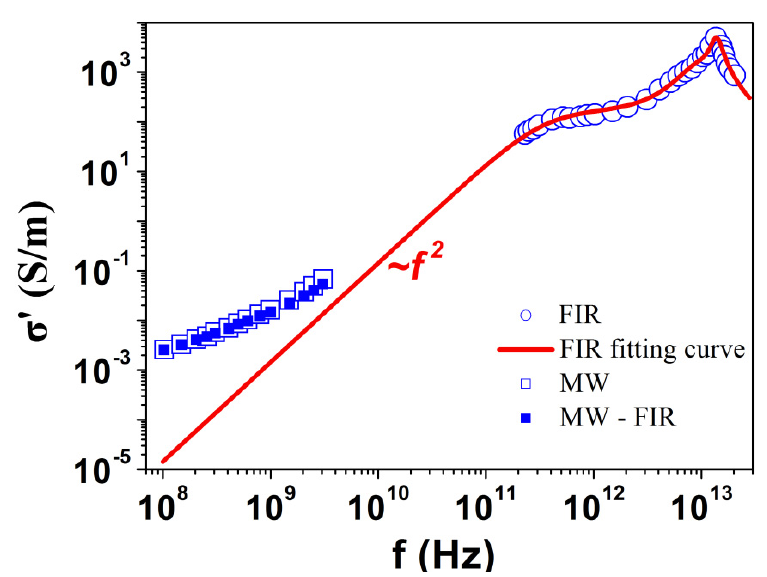
Figure 3. Real part of AC conductivity as a function of frequency of a lithium silicate glass. The blue open symbols represent experimental data points of FIR (circles) and MW (squares) frequencies (Data were taken from literature [29]). The blue solid squares represent MW data after the subtrac- tion of FIR contribution. The red line is the best fitting of a sum of three terms ε o ω i Im [ DHO ] i . The fitting parameters’ values are: γ 1 /2 π = 1.12 × 10 13 (Hz), A 1 /(2 π ) 2 = 3.20 × 10 25 (Hz 2 ), ω ο 1 /2 π = 1.94 × 10 12 (Hz), γ 2 /2 π = 9.71 × 10 12 (Hz), A 2 /(2 π ) 2 = 1.98 × 10 26 (Hz 2 ), ω ο 2 /2 π = 9.89 × 10 12 (Hz), γ 3 /2 π = 3.79 × 10 12 (Hz), A 3 /(2 π ) 2 = 2.84 × 10 26 (Hz 2 ) and ω ο 3 /2 π = 1.37 × 10 13 (Hz).